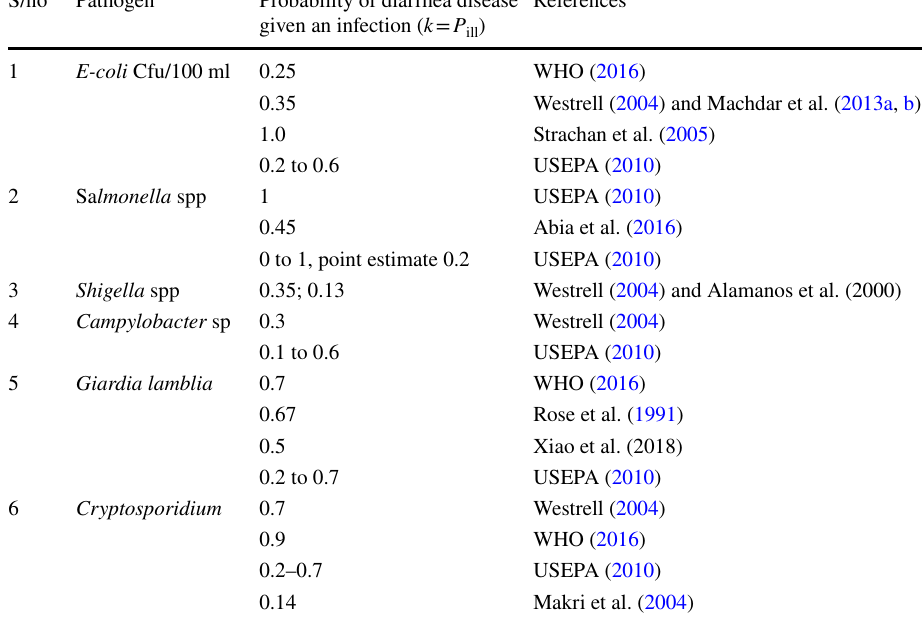
Table 2 Probabilities of diarrhea given infection of